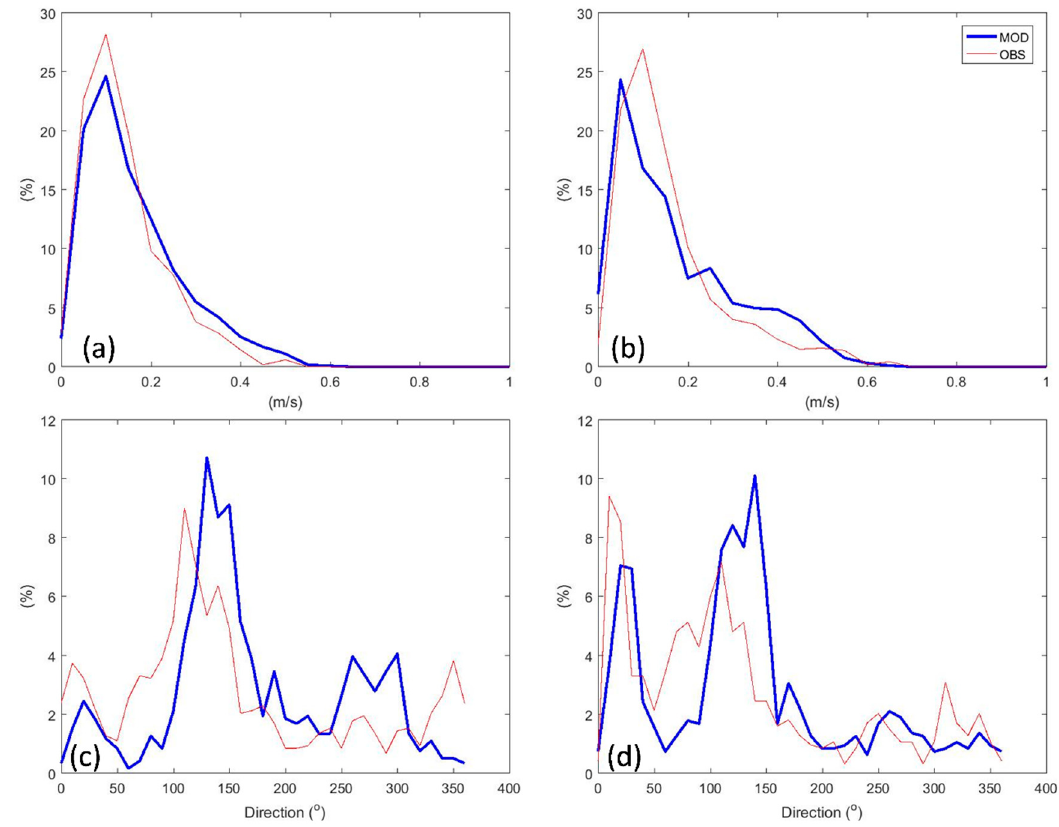
Figure 15. Probability density function of current speeds ( a , b ) and directions ( c , d ) derived from model results (blue lines) and observations (red lines) between 1 November and 31 December 2014, at ( a , c ) 181 m and ( b , d ) 196 m.